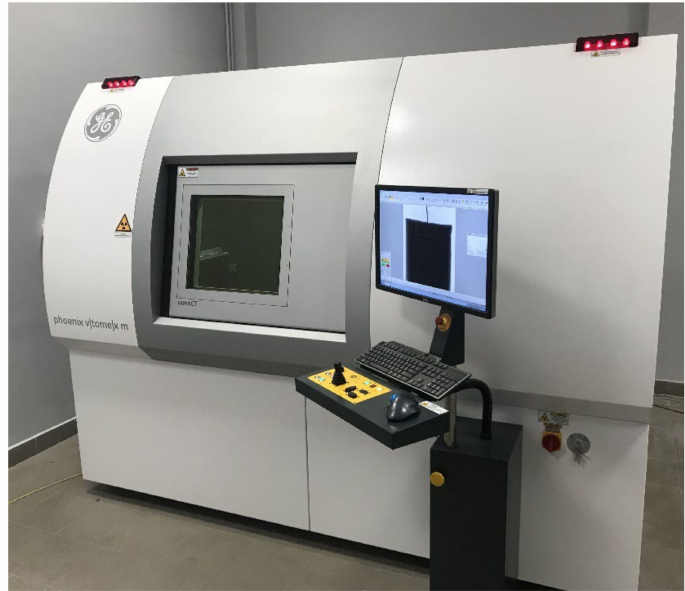
Figure 1. X-ray CT scanner GE phoenix v|tomex|m.